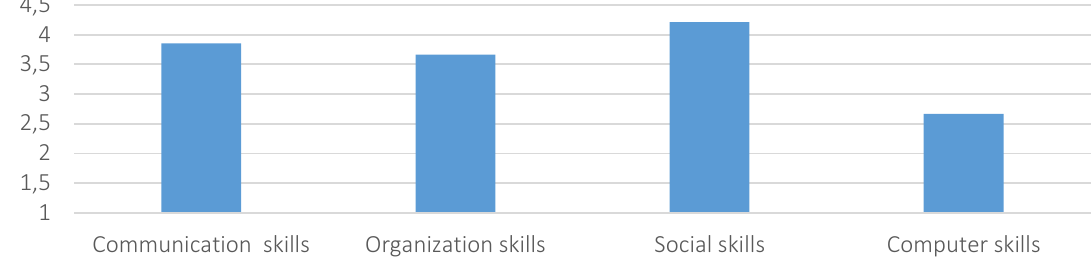
Figure 2. Importance of volunteers’